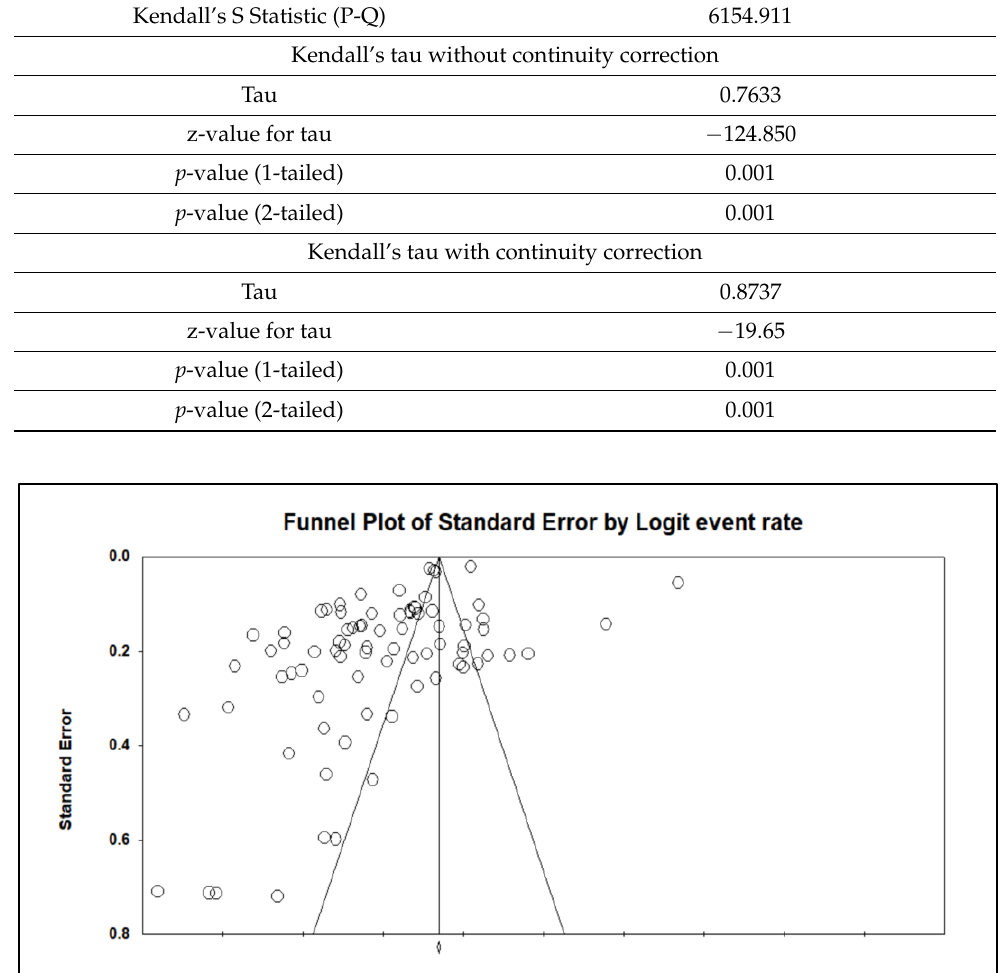
Table 3. Begg ’s and Mazumdar ’s rank correlation.